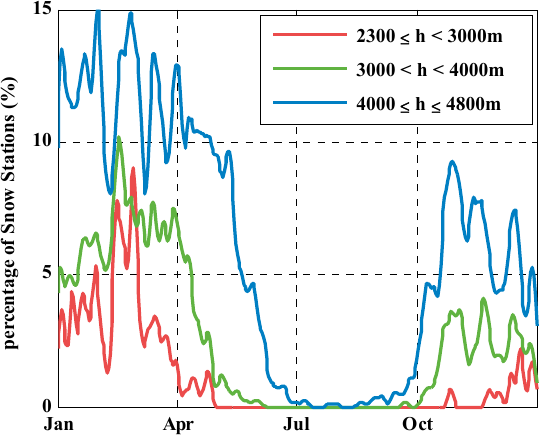
Figure 9. The 2001–2015 average percentages of snow stations for three altitude ranges smoothed by an eight-day moving average filter.